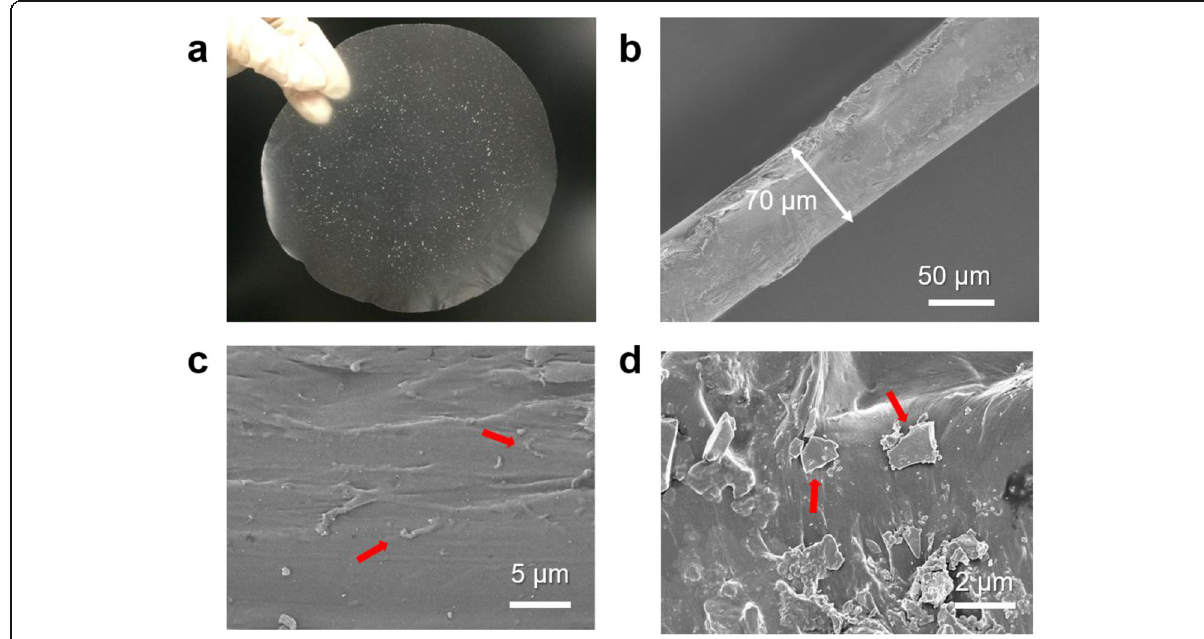
Fig. 3 Photographs of the LN/PP/MWCNT film. a An intact piece of the LN/PP/MWCNT film. b SEM images of a cross section of the LN/PP/ MWCNT film. The magnified cross section of where MWCNT c and LN particles d are indicated by red arrows